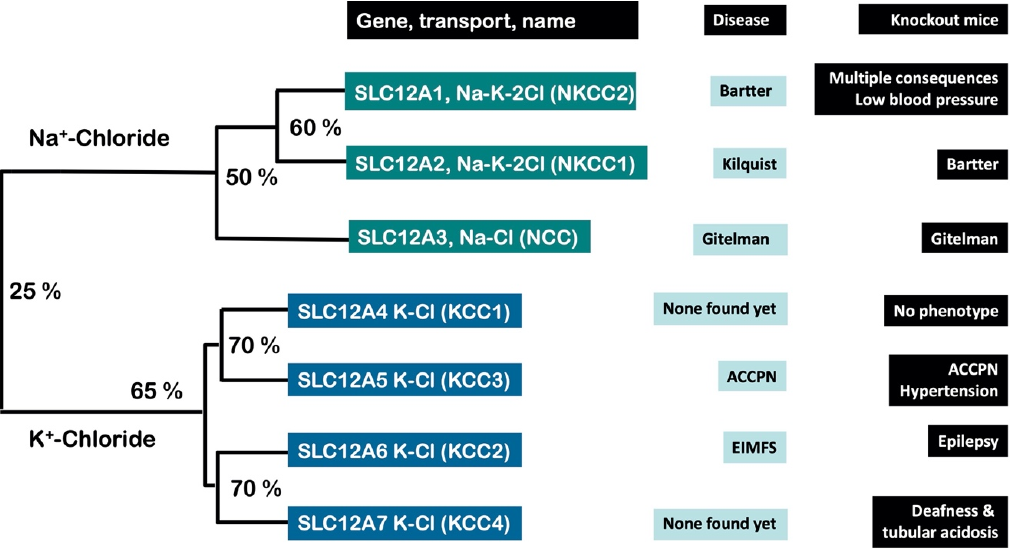
Figure 2. The SLC12A family of electroneutral cation chloride cotransporters. Seven members composing the Na + ‐ driven and the K + ‐ driven branches are shown, but there are two most distant members SLC12A8 and SLC12A9 not shown. The figure depicts the gene name, the cotransporter’s behavior, the human disease produced by inactivating mutations and the phenotype of the knockout mice. The percentages depict the molecular identity among members of the family. ACCPN = agenesis of the corpus callosum polyneuropathy. EIMFS = epilepsy of infancy with migrating focal seizures.